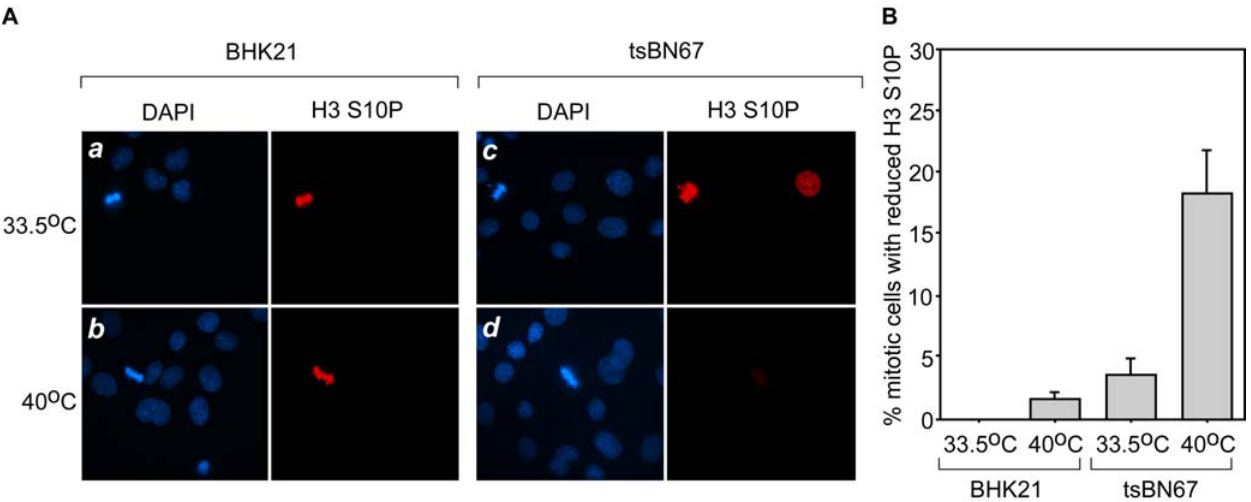
Figure 7. H3S10P status in mammalian cells defective for HCF-1 function. H3S10P status in BHK21 (panels a and b ) and tsBN67 (panels c and d ) cells visualized by immunostaining. Cells were grown at permissive (33.5 u C; panels a and c ) and nonpermissive (40 u C; panels b and d ) temperatures. Nuclei were stained with DAPI (blue labeling) and anti-H3S10P antisera (red labeling). (B) Percentage of mitotic BHK21 and tsBN67 cells displaying a reduced H3S10P staining at the permissive (33.5 u C) and nonpermissive (40 u C) temperatures. The results are the average of three independent samples in which for each sample 50 mitotic cells were analyzed.